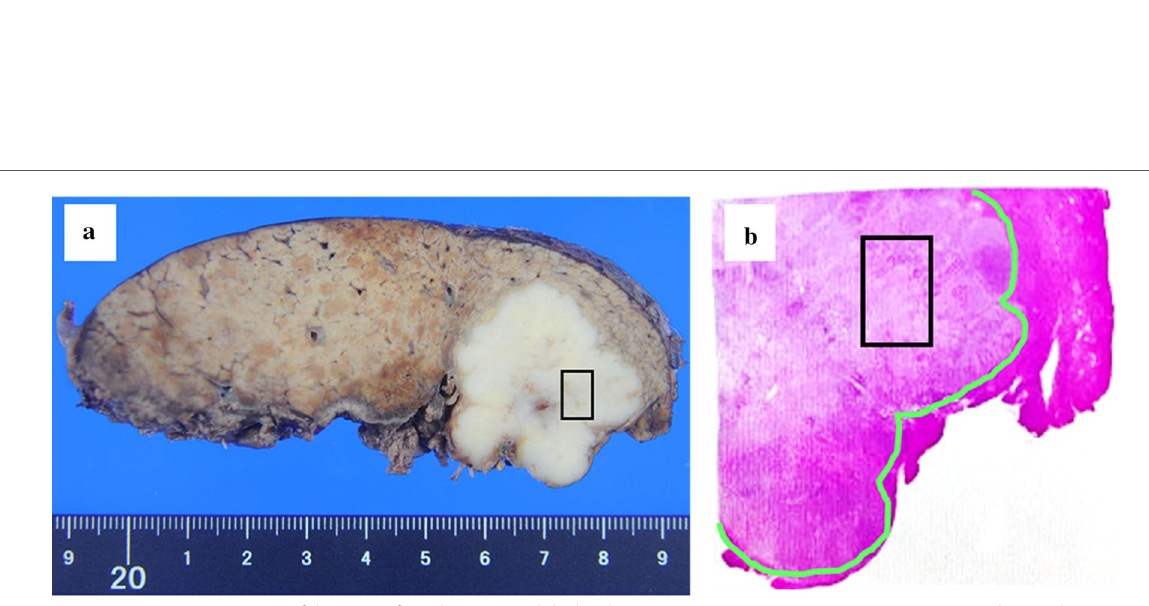
32 mm 30 mm with irregular margins. In × ×